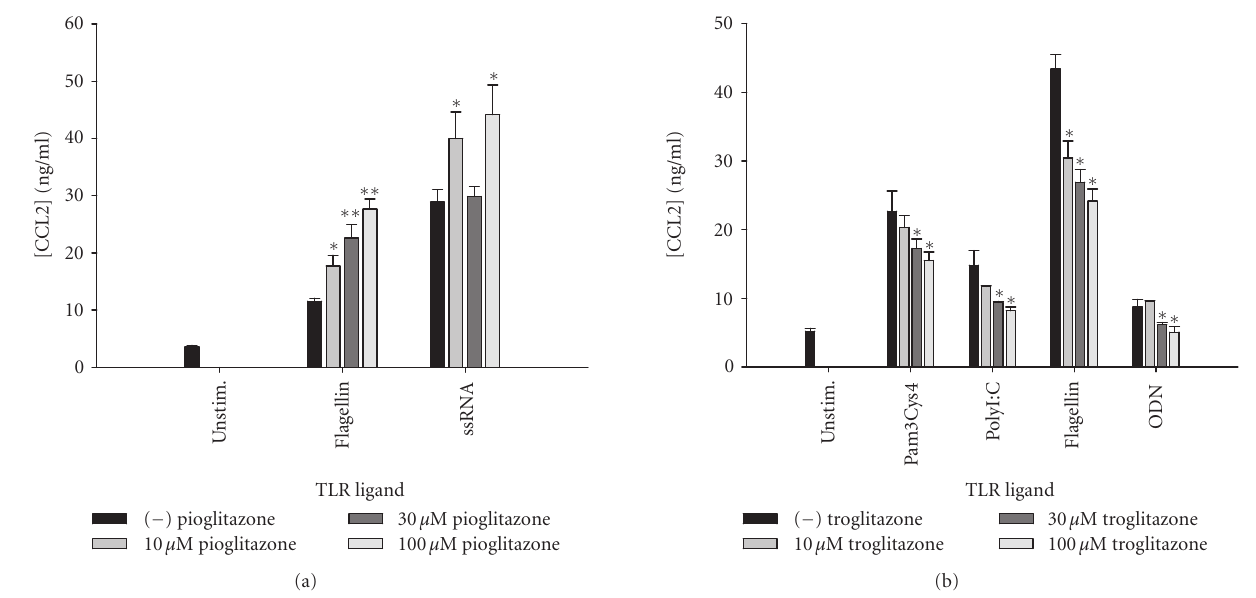
Figure 15: TZDs exert di ff erential e ff ects on astrocytic CCL2 production following TLR ligand treatment. Primary astrocytes were plated at 1 × 10 5 cells/well in 96-well plates and incubated overnight. The following day, cells were pretreated for 1hour with the indicated concentrations of pioglitazone (a) or troglitazone, (b) prior to the addition of TLR ligands. Cell-conditioned supernatants were collected at 24hours following TLR ligand exposure, whereupon CCL2 levels were determined by ELISA (a) and (b). Significant di ff erences between astrocytes treated with TLR ligands alone versus TLR ligands + TZDs are noted with asterisks ( ∗ P < . 05; ∗∗ P < . 001). Results presented are representative of two independent